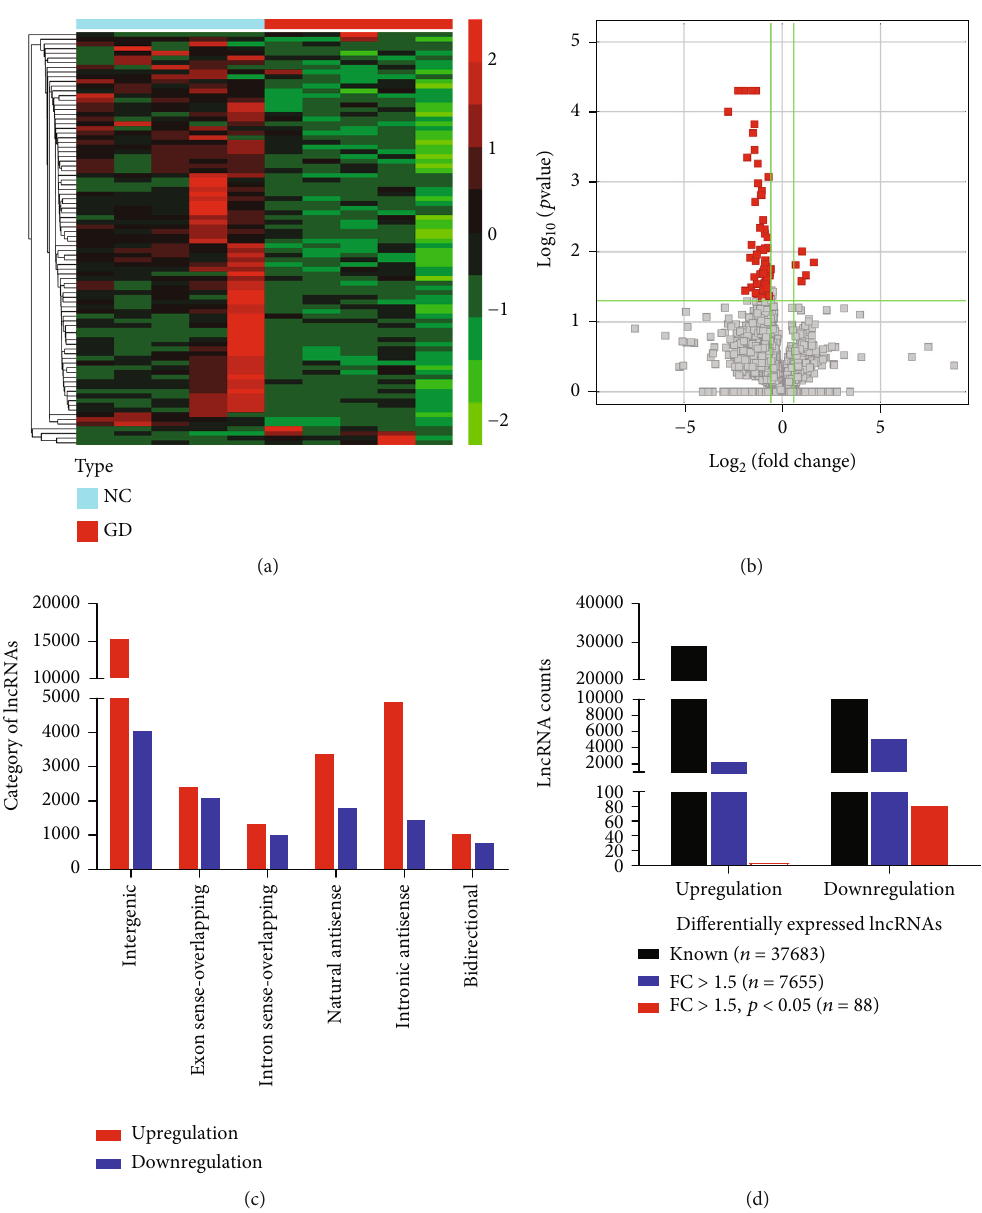
Figure 1: The expression pro fi le of lncRNAs in GD. (a) Hierarchical clustering of di ff erentially expressed lncRNAs in PBMCs between the GD and NC groups. The red squares represent upregulated lncRNAs, and the green squares reveal downregulated lncRNAs. (b) Volcano plot of dysregulated lncRNAs between the two groups. The red dots indicate signi fi cantly di ff erentially expressed lncRNAs ( FC > 1 : 5 and p < 0 : 05 ). (c) The category of dysregulated lncRNAs in GD. (d) A total of 27,354 upregulated and 10,329 downregulated lncRNAs were identi fi ed in the GD group compared with the NC group (black). Among them, 2,469 lncRNAs showed upregulated expression and 5,186 showed downregulated expression with over a 1.5-fold change in GD (blue). Eighty-eight signi fi cantly di ff erentially expressed lncRNAs, including 5 upregulated and 83 downregulated lncRNAs, were identi fi ed ( FC > 1 : 5 and p < 0 : 05 ) (red). Each data point represents an individual